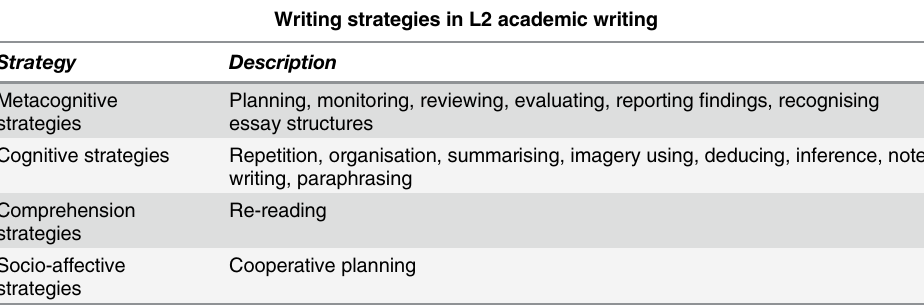
Table 1. Writing strategies in L2 academic